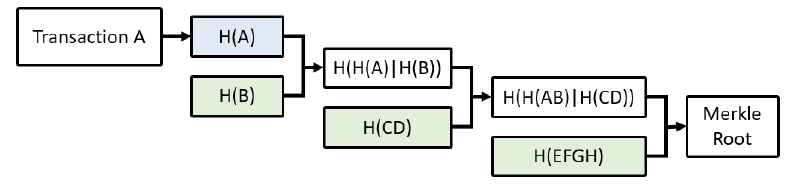
Figure 5. The verification of Merkle